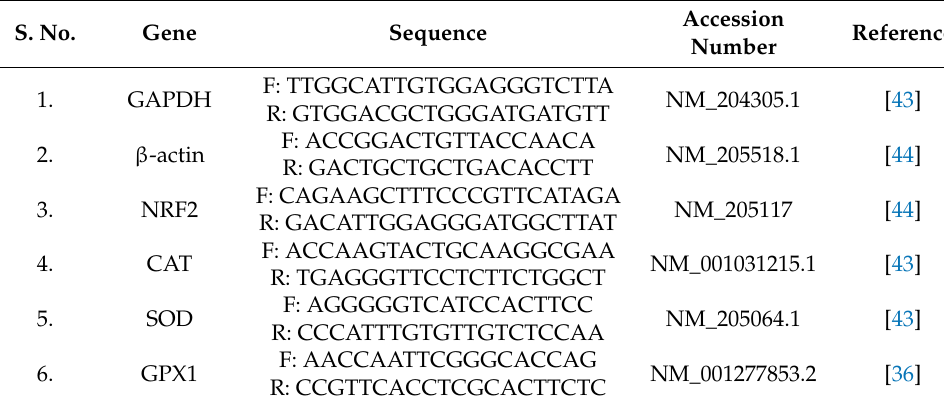
Table 1. Oligonucleotide primer sequence for